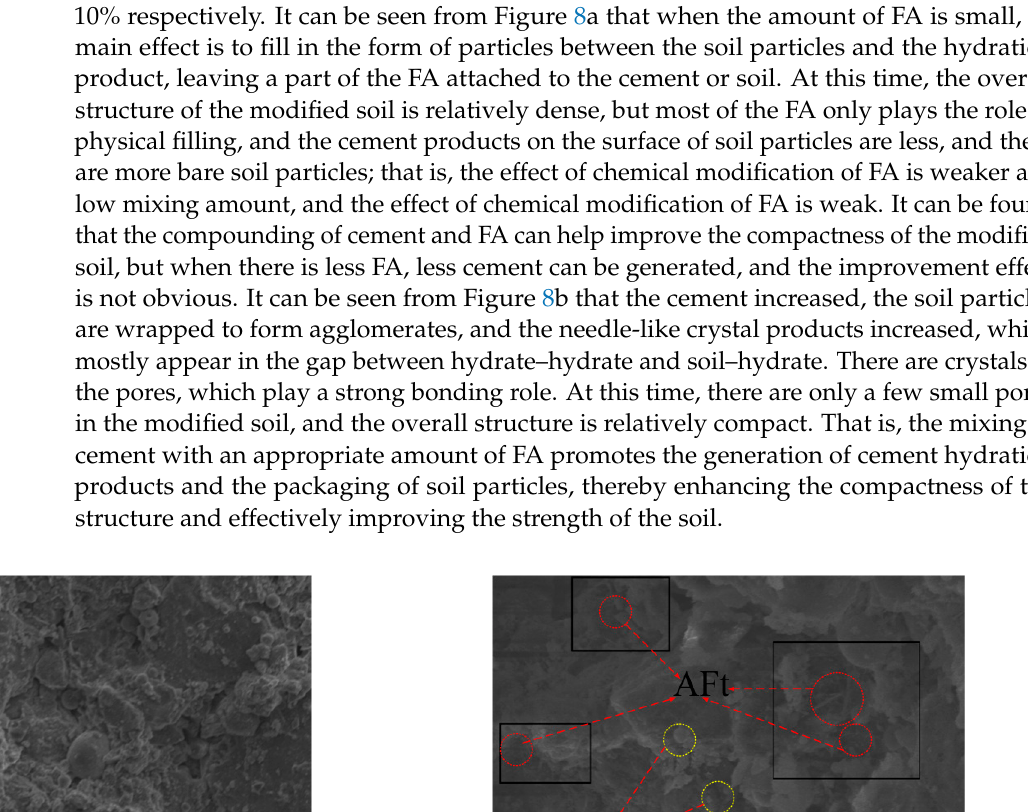
Figure 7. SEM picture of plain cement–soil.